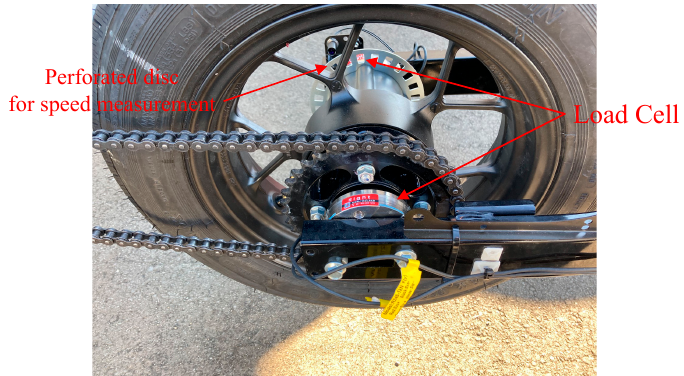
Figure 14. Constructed measurement trailer system.